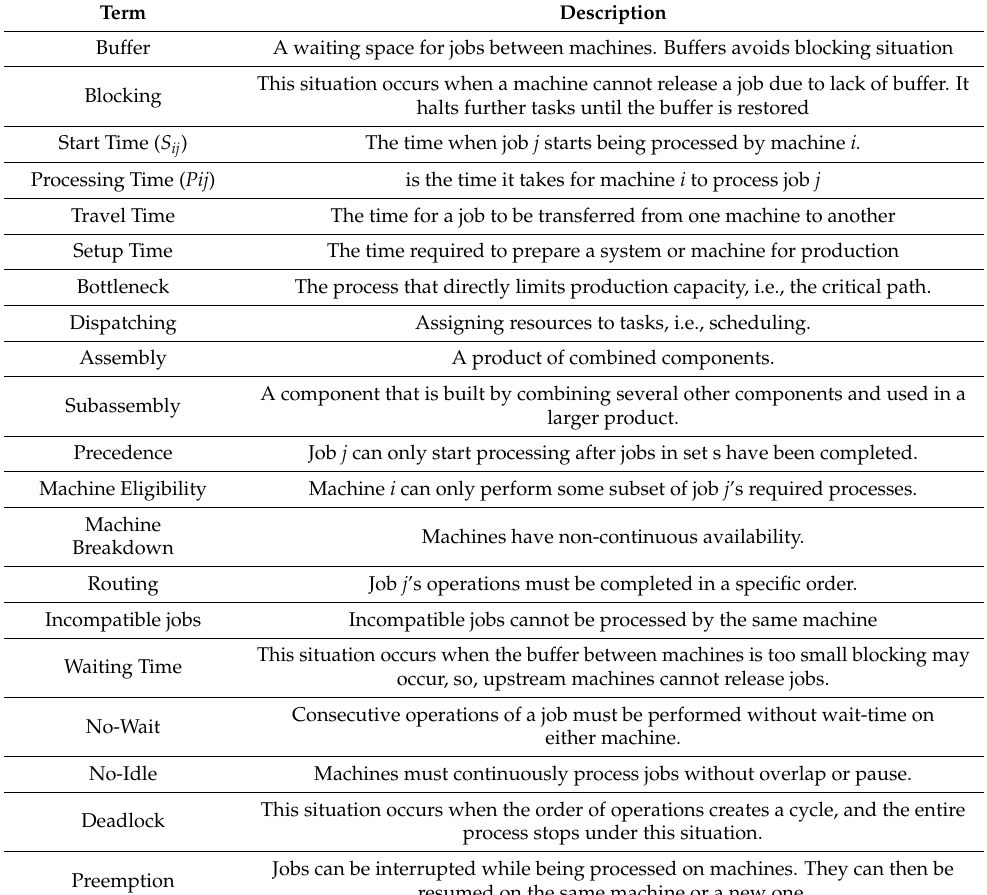
Table 3. Common terminology in Manufacturing system and shop scheduling problems.